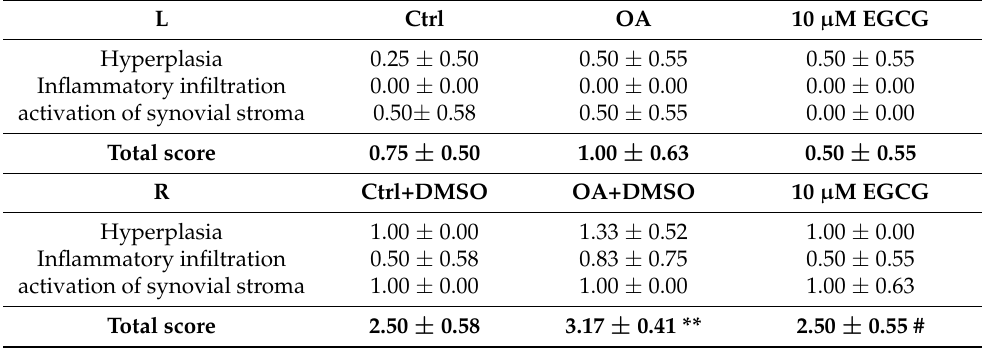
Figure 4. Representative sections of synovial membrane from both knee joints of rats. ( a ) Sample from a rat after sham operation (control group). Note the low-grade inflammatory cell infiltrate and the mild increases of synovial hyperplasia and stroma activation. ( b ) Sample from a rat after anterior cruciate ligament transection (OA group), in which there is more infiltration by inflammatory cells. ( c ) Sample from a rat after ACLT and treated with EGCG (10 µ M EGCG group) shows similar sham-operated joints with a fewer infiltrating cells than the OA joint. Table 3. Grading of chronic synovitis. * p < 0.05 OA vs. control; ** p < 0.01 OA vs. control; # p < 0.05 OA vs.